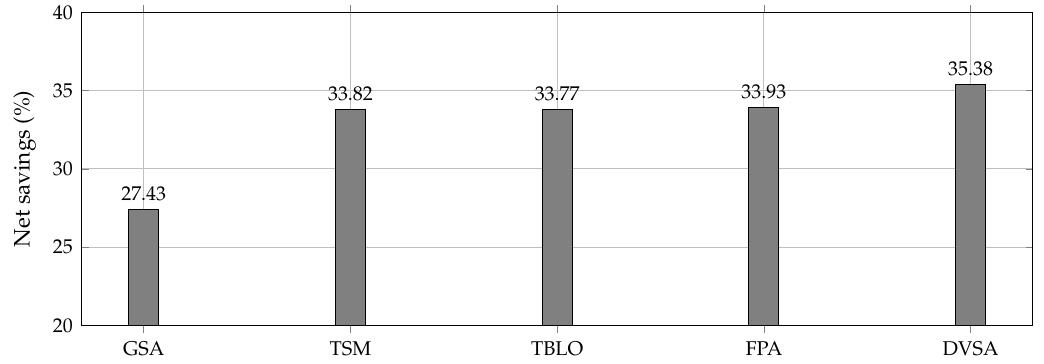
Figure 7. Percentage of energy saving costs after locating capacitor banks in the 69-node test